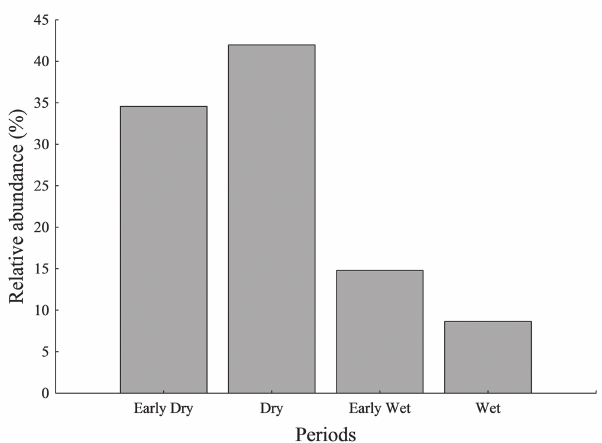
Fig. 3. Relative abundance (%) of Mylesinus paucisquamatus among seasonal periods, considering all data sets combined, e.g. , 81 individuals captured between 1998 and 2009, upper rio